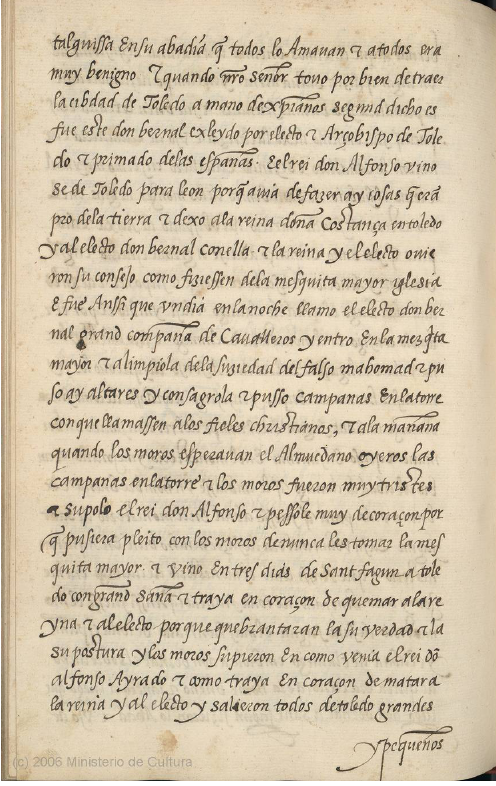
Figure 3. Page 515 of the Rodrigo